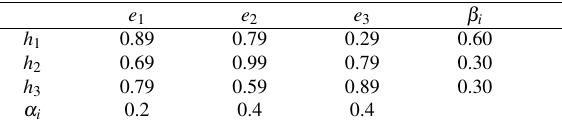
Table 11: Tabular representation of L (( F , A ) , 0 . 33 ) with choice values e 1 e 2 e 3 Choice value h